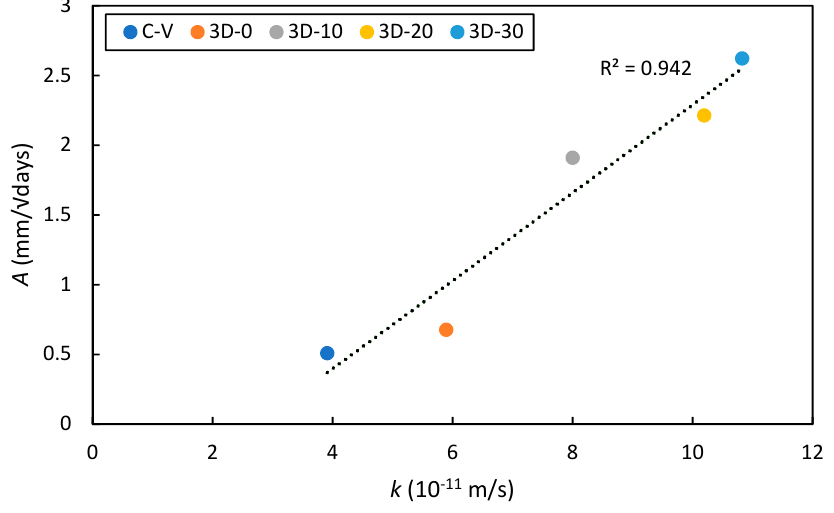
Figure 18. Correlation between the k and the A.